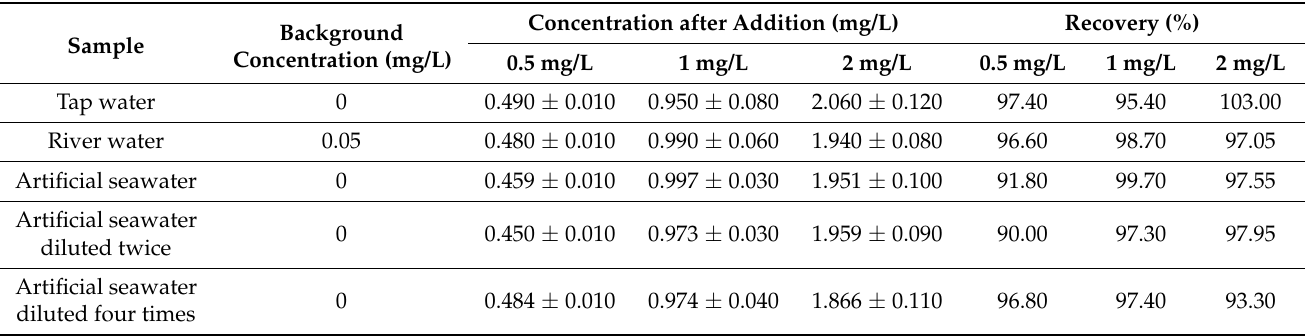
Table 3. The recovery of the test kit method ( n =